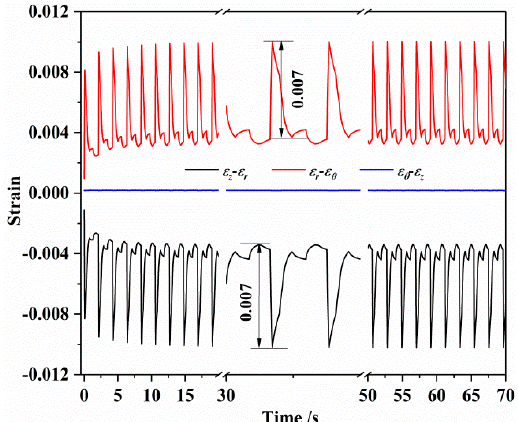
Figure 10. Difference of principal strains at the roll surface during the first strip rolling. Figure 10. Di ff erence of principal strains at the roll surface during the first strip